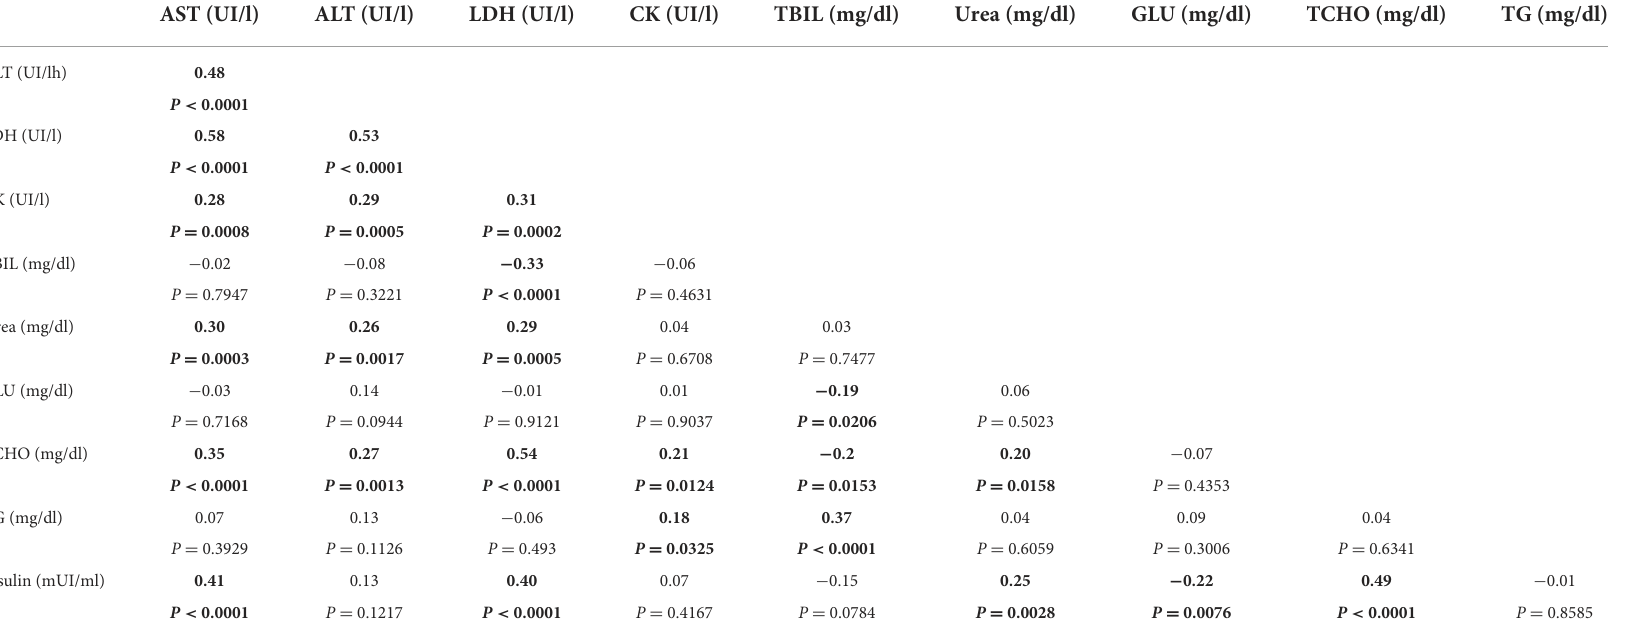
TABLE 4 Pairwise correlations for all the included blood